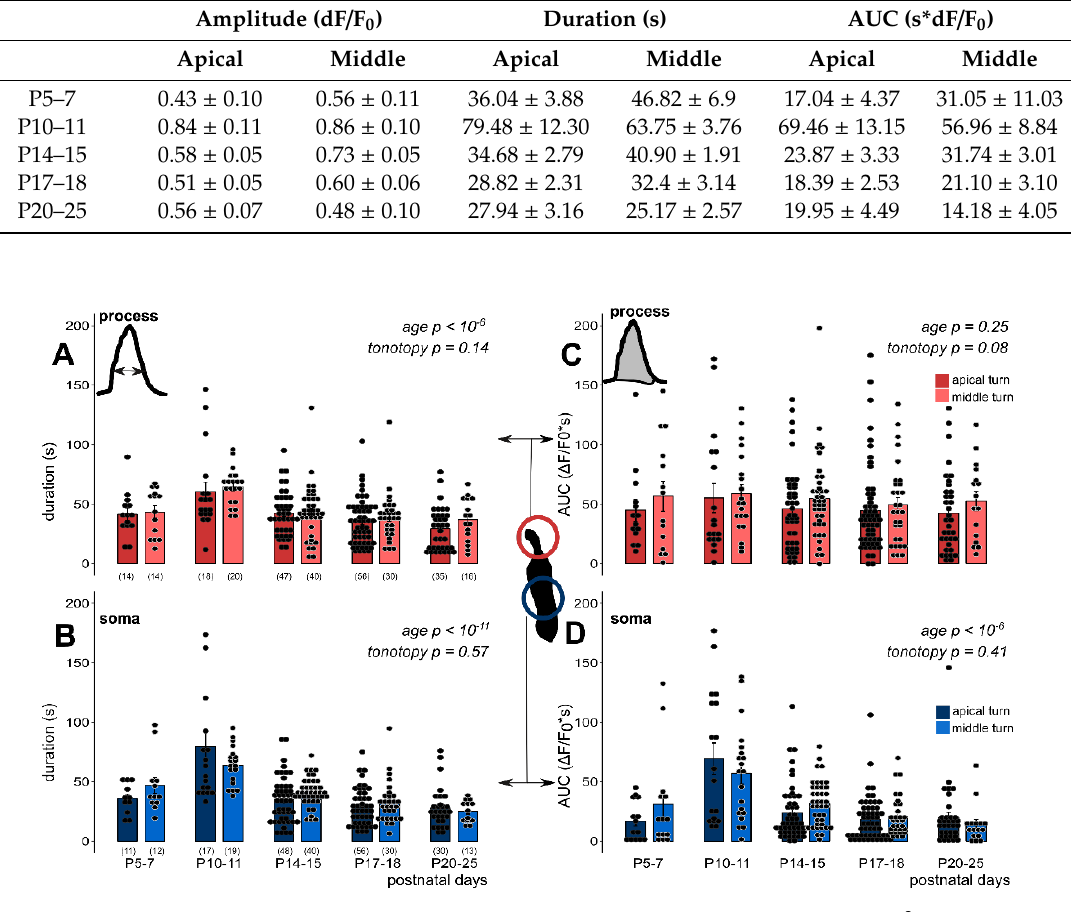
Figure 4. Duration and area under the curve (AUC) of exogenous ATP-evoked (100 µM) Ca 2+ transients depend on the developmental state but lack tonotopic difference in phalangeal processes and somas of Deiters’ cells in the mouse hemicochlea preparation. The bar graphs show the durations ( A , B ) and AUC values ( C , D ) of all measured cell responses and their averages ± SEM in the processes ( A , C ) and somas ( B , D ) in the apical (darker colors) and middle (lighter colors) cochlear turns. Note the maturation-dependent gradual decrease in both the response duration and the AUC in both subcellular compartments (except in AUC in the process) from P10–11, which is the onset of mouse hearing. There was no significant turn difference between the apical and middle cochlear turn in either parameter or subcellular compartment. Number of experiments are in parenthesis ( A , B ) and they are the same for the appropriate variables in C and D. Respective p values, showing the significance of age or tonotopy are written in italics. Details of statistical analysis are given in the Materials and Methods.